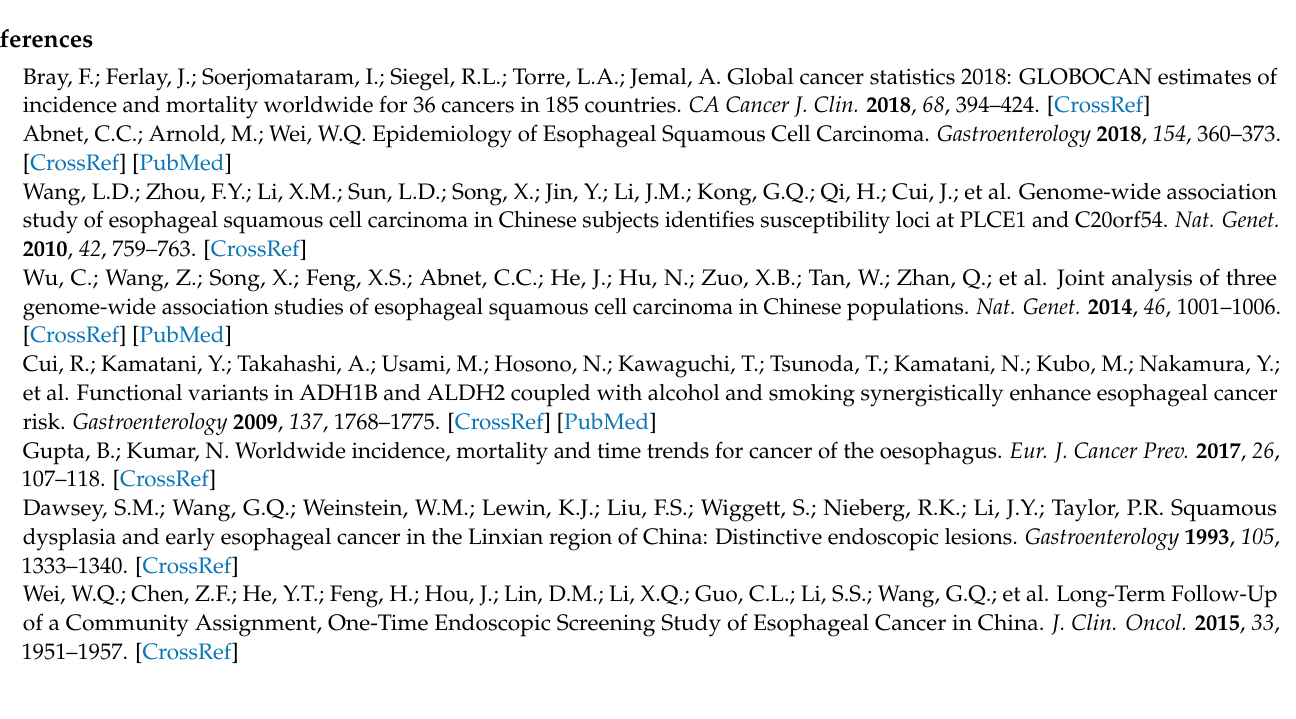
Table S2: The IC 50 of various genotoxic compounds in U2OS overexpressing vector alone